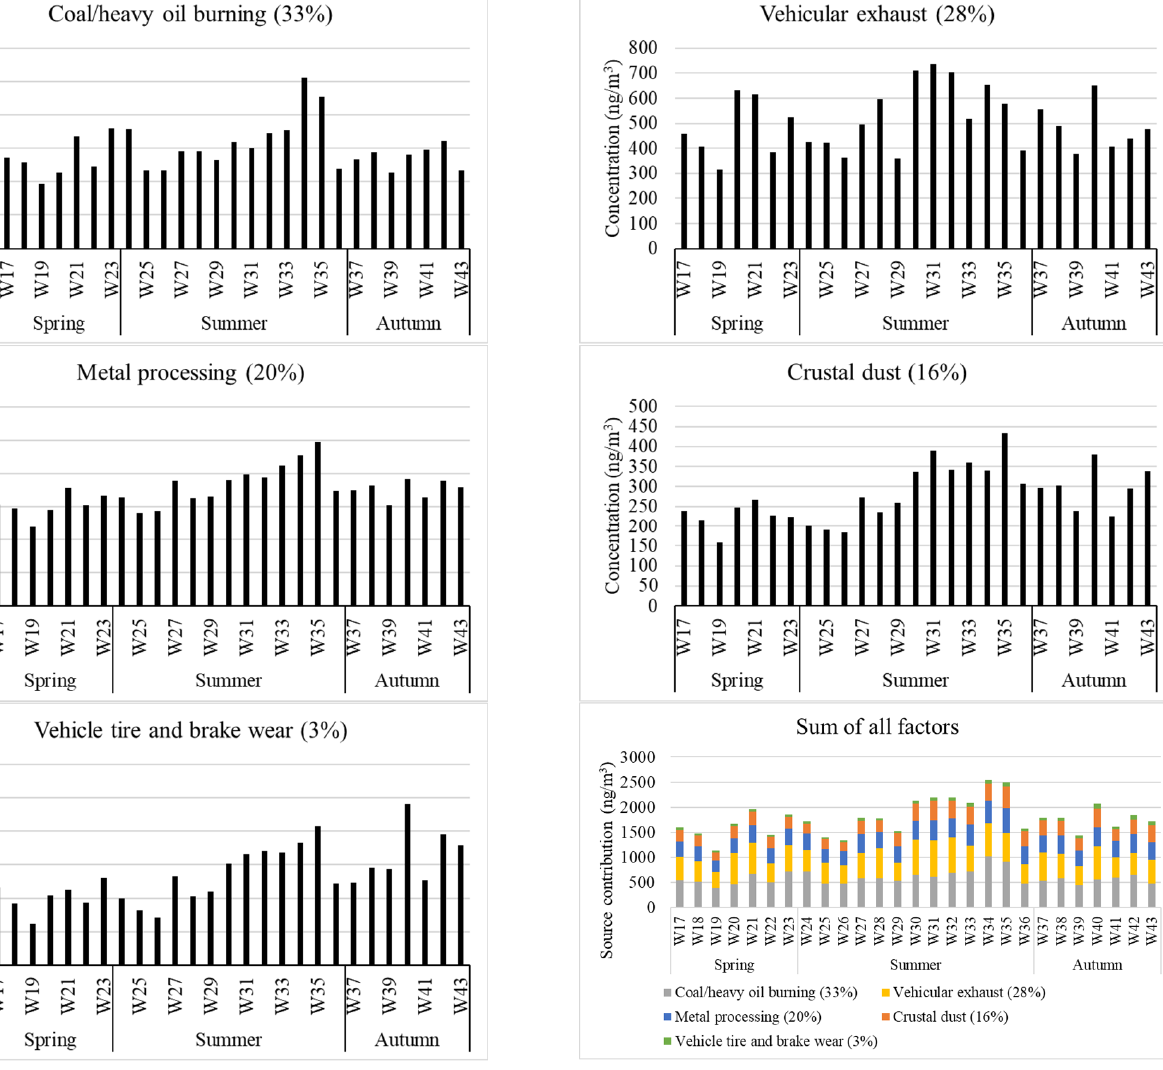
Figure 3. Weekly averaged source contributions to ambient PM 2.5 -bound elements. Percentages in the bracket are averaged source contributions. Week 17 started on 20 April 2021 and W43 started on 17 October 2021. Spring is from April to May, summer is from June to August, and fall is